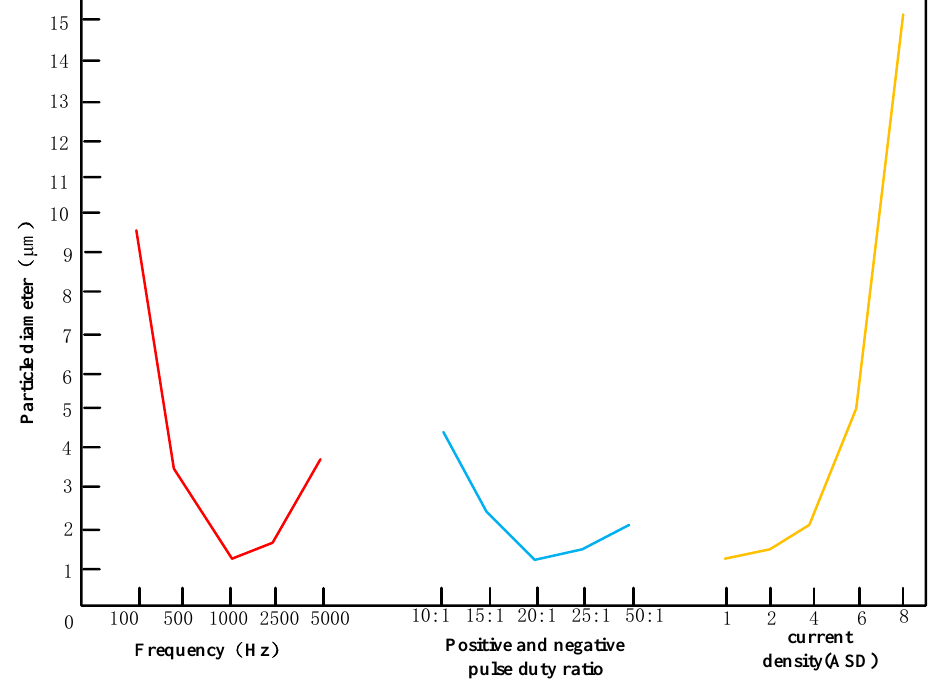
Figure 10. Relationship between pulse plating parameters and the rate of change of plating particle diameter.